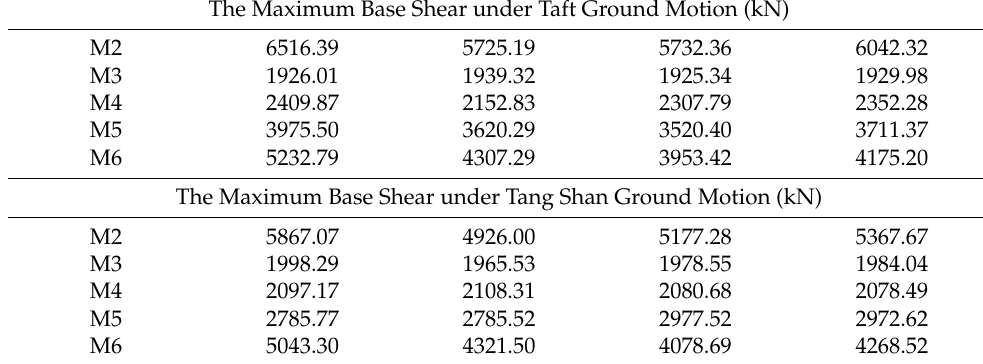
( e ) Figure 13. The interstorey drift ratio of different models under taft ground motion: ( a ) M2; ( b ) M3; ( c ) M4; ( d ) M5; ( e ) M6. 6. Conclusions